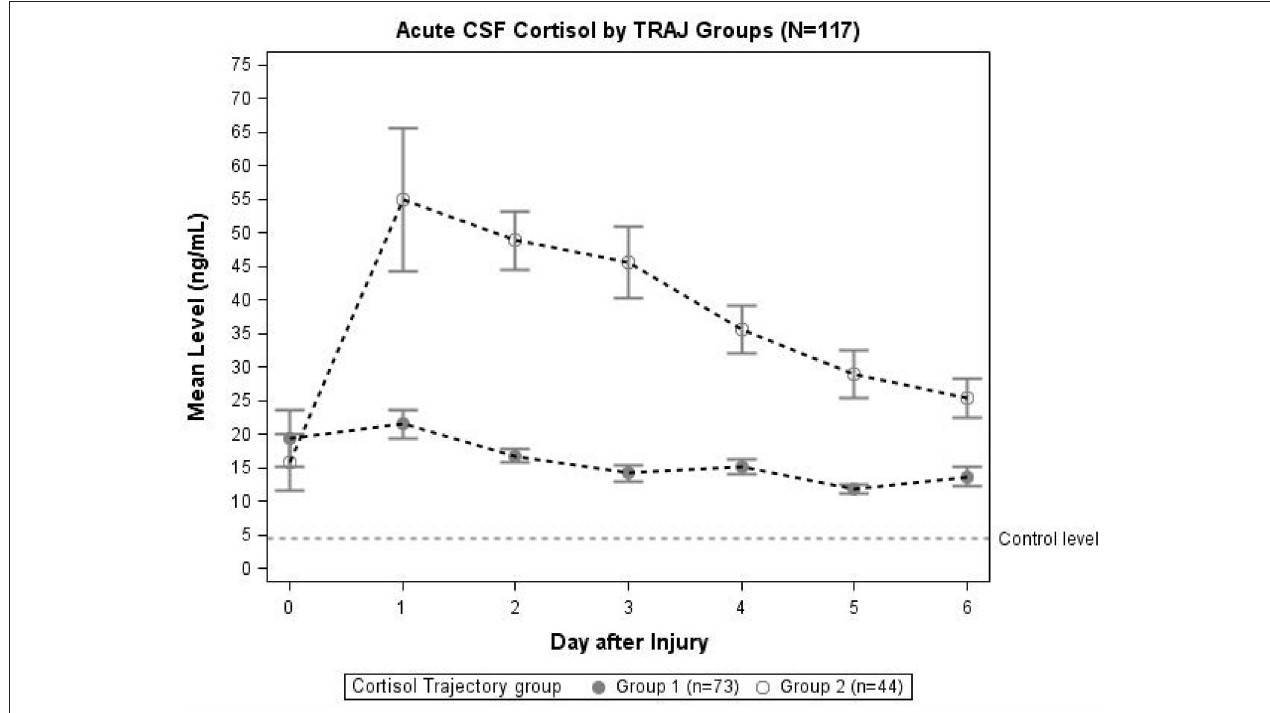
FIGURE 2 | Daily mean CSF cortisol levels for CSF cortisol TRAJ groups ( N = 117). Daily mean CSF cortisol levels for the cortisol TRAJ groups. Error bars indicate standard error of the mean. There was a significant difference in CSF cortisol levels between the two groups on days 1–6 ( p < 0.01). CSF cortisol values are provided for N = 13 healthy controls as a